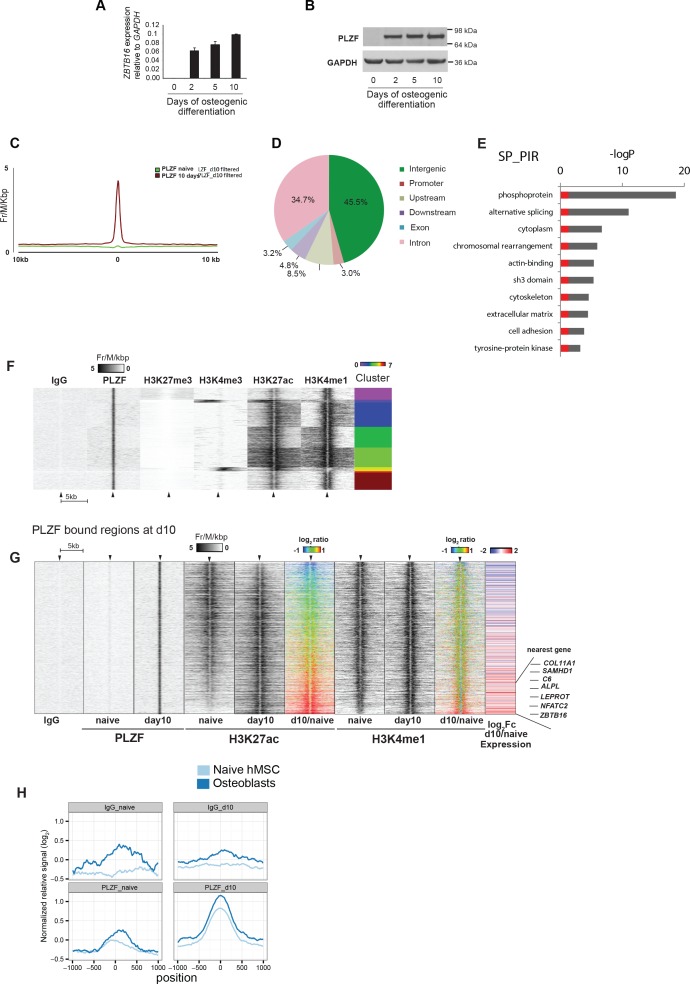
PLZF induction and binding to enhancers during osteoblasts commitment of progenitor cells.(A) PLZF expression during early osteogenic differentiation of hMSCs shown by (A) RT-QPCR (ZBTB16) and (B) western blot. GAPDH was used as a loading control. (C) Average tag density plot for PLZF peaks from ChIP-seq in naive hMSCs or immature-osteoblasts (day 10). Peak finding revealed 2,282 specific PLZF peaks in immature-osteoblasts (Supplementary file 4). See Supplementary Methods for details regarding peak finding analyses. (D) Pie chart showing the percentage of PLZF peaks (n = 2,282) that overlapped with different genomic regions; promoter (−1 kb to TSS, n = 70); upstream (−10 kb to TSS excluding promoters, n = 195); downstream (+10 kb from the end of the gene, n = 110); exon (n = 75); intron (n = 792); and intergenic (> ± 10 kb from TSS or end of the gene, n = 1,040). (E) GO term analyses of genes nearby to PLZF peaks (n = 2,282) observed by DAVID (The Database for Annotation, Visualization and Integrated Discovery) (Huang da, Bailey et al., 2009). The key words enriched are displayed in the plot. The Y-axis represents the Benjamini Hochberg corrected –LogP value. Grey parts of the bars are above a 0.05 cut-off. (F) Heat-maps at PLZF peaks (n = 2,282) clustered according to local densities of the H3K27me3, H3K4me3, H3K27ac and H3K4me1 histone marks in immature-osteoblasts. ChIP-seq signals from each antibody were normalized to library sizes and visualized at PLZF peaks ± 5 kb. Only PLZF peaks specific for day 10 of osteogenic differentiation were included, and peaks with PLZF signal at day 0 were excluded (for threshold and genomic peak positions please see Supplementary file 3, and Supplementary methods). (G) Heat maps showing the changes in H3K27ac and H3K4me1 at PLZF peaks (n = 2,282), and expression of the nearest gene in naive hMSCs (day 0) and immature osteoblasts. The distribution of normalized H3K27ac or H3K4me1 ChIP seq signal in naïve hMSCs or immature osteoblasts is shown in the heat maps, centered at PLZF peaks identified in immature osteoblasts (± 5 kb). The ratiometric heatmap depicts the changes in H3K27ac and H3K4me1 levels in immature-osteoblasts compared to naive hMSCs (log2fc day10/naïve) and all heatmaps were sorted according to the H3K27ac ratio with the highest day10/naive H3K27ac ratio at the bottom. Gain is colored red (log2 fold ≥ 1, corresponds to 403 PLZF peaks), no change is colored green (log2 fold>-1 and < 1, n = 1,844 PLZF peaks) and loss is colored blue (log2 fold ≤ 1, n = 35 PLZF peaks). The RNA-seq based heat-map shows the log2fc in expression (day10/naive) of nearest transcript mapped to the center of individual PLZF peaks. Transcripts with induced expression are colored red, while blue coloring reflects decreased expression between naïve hMSCs and immature osteoblasts. Examples of genes with increased expression correlating with increased H3K27ac and PLZF binding at nearest genomic region (enhancer) are indicated on the right side. COL11A1, Collagen11A1; SAMHD1, SAM domain and HD domain1; C6, Complement Component 6; NFATC2, nuclear factor of activated T-cells; ALPL, Alkaline Phosphatase; LEPROT, Leptin Receptor Overlapping Transcript; ZBTB16, Zinc Finger and BTB Domain Containing Protein 16. (H) Average normalized ChIP-seq pile-up signal from PLZF or IgG control in naive hMSCs or immature-osteoblasts,± 1 kb around midpoints of enhancers (defined by FANTOM5) transcribed in mesenchymal stem cells (naive hMSCs) and osteoblasts. Pile-up signal was normalized to the average base pair signal across all FANTOM5 enhancers (n = 43,011).